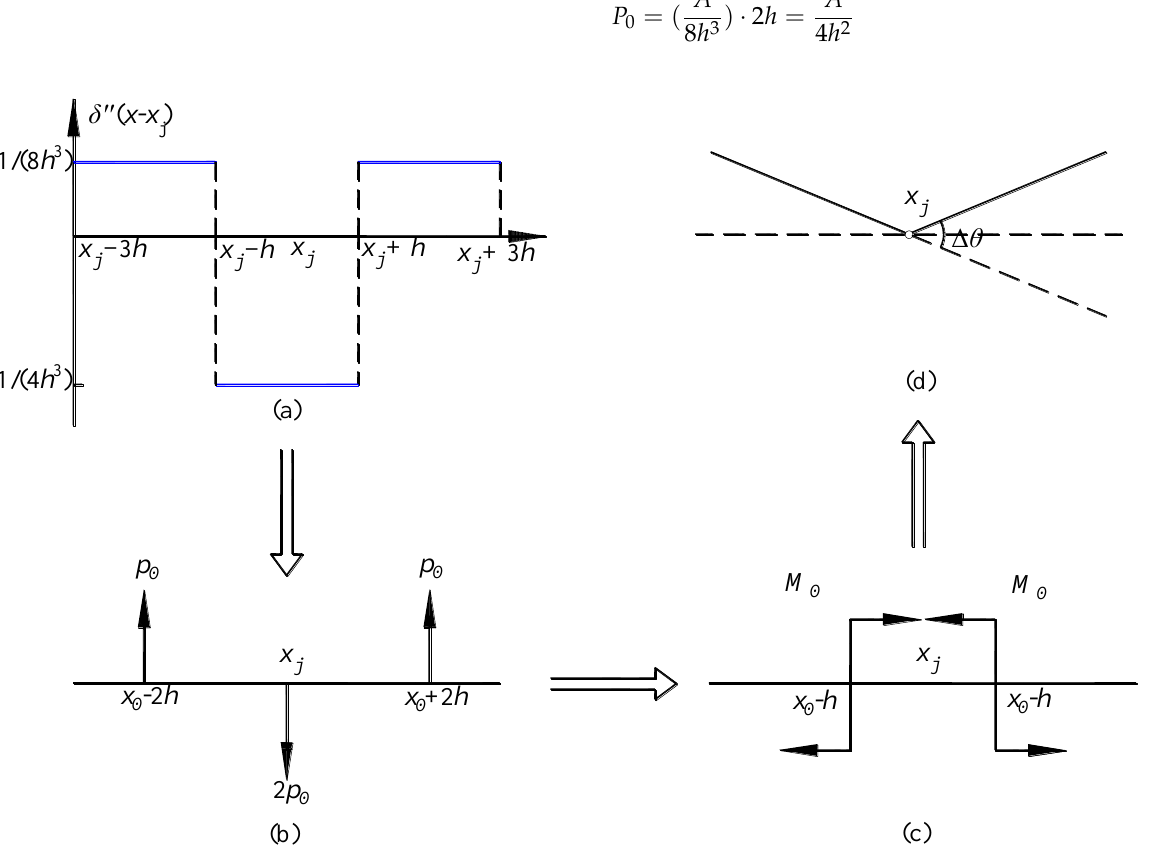
Figure 6. Additional local rotation can be realized by introducing an additional moment. ( a ) Pulse function; ( b ) Equivalent concentrated forces; ( c ) Additional moment at joints; ( d ) Related rotation at joints.